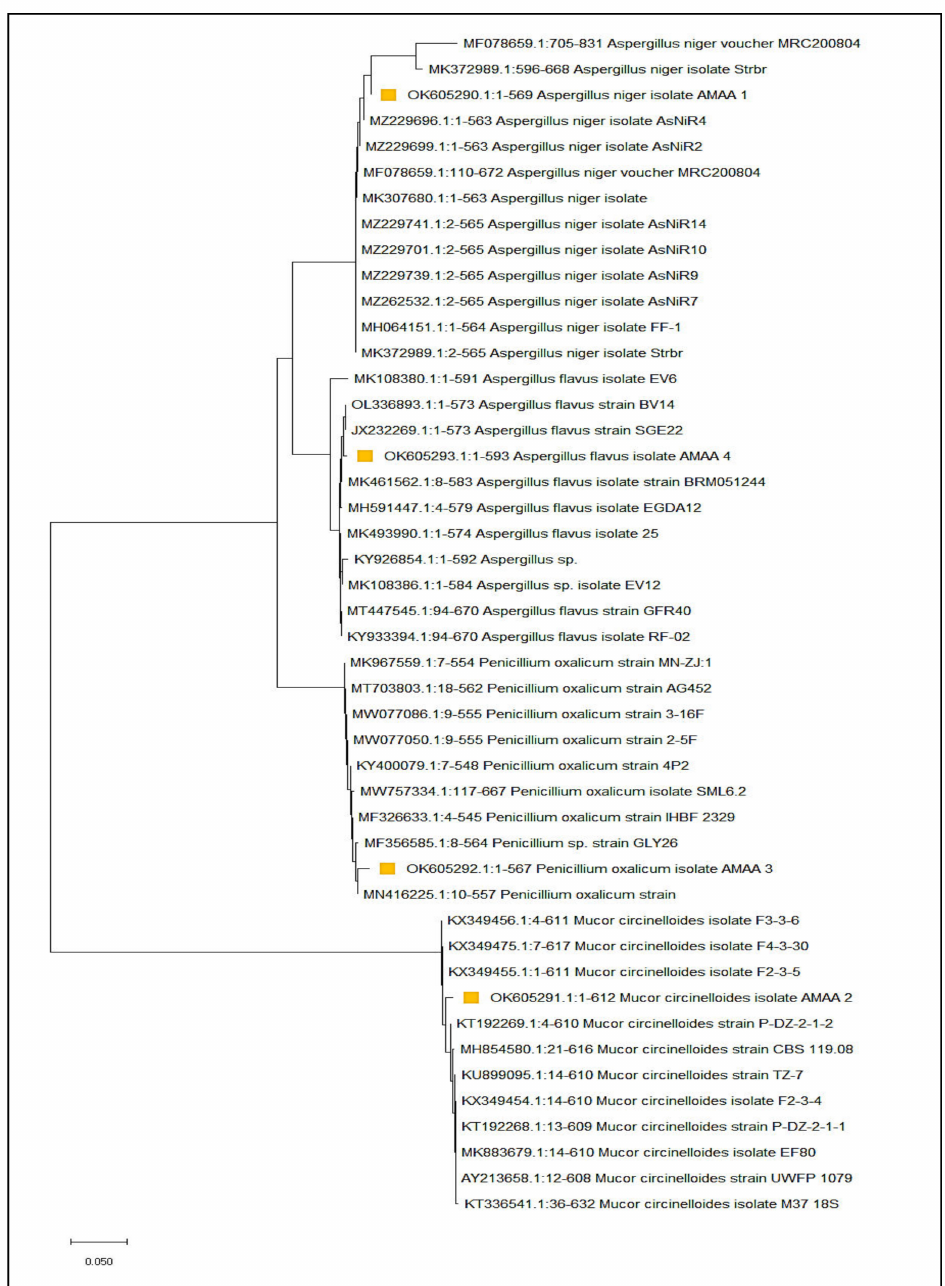
Figure 1. Phylogenetic tree of A. flavus , P. oxalicum , M. circinelloides and A. niger with accession numbers OK605293, OK605292, OK605291 and